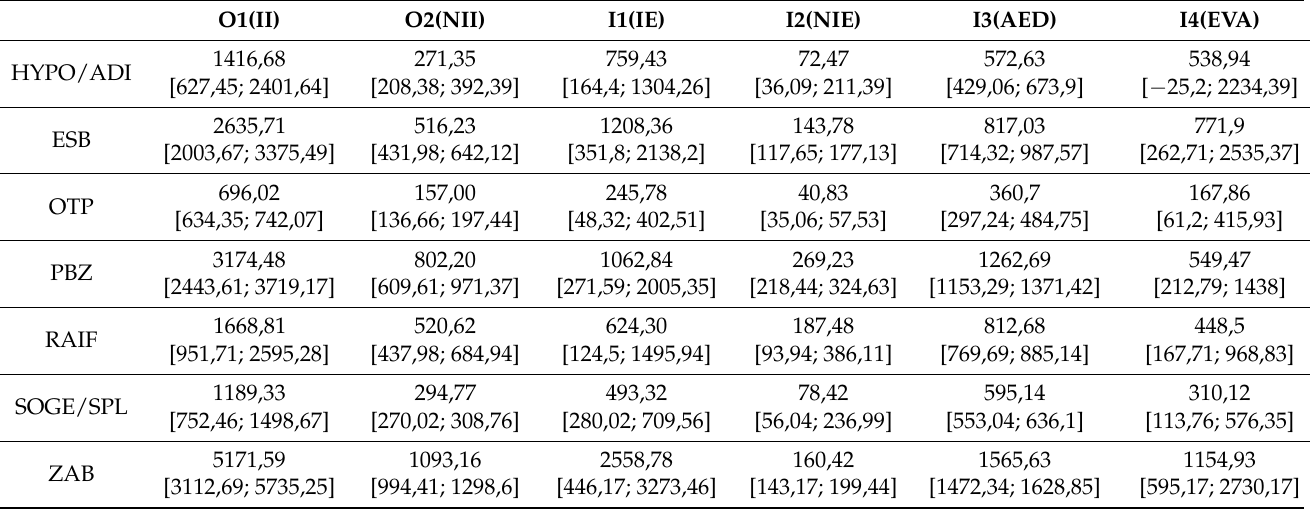
Table 1. Data averages, [min and max], in million